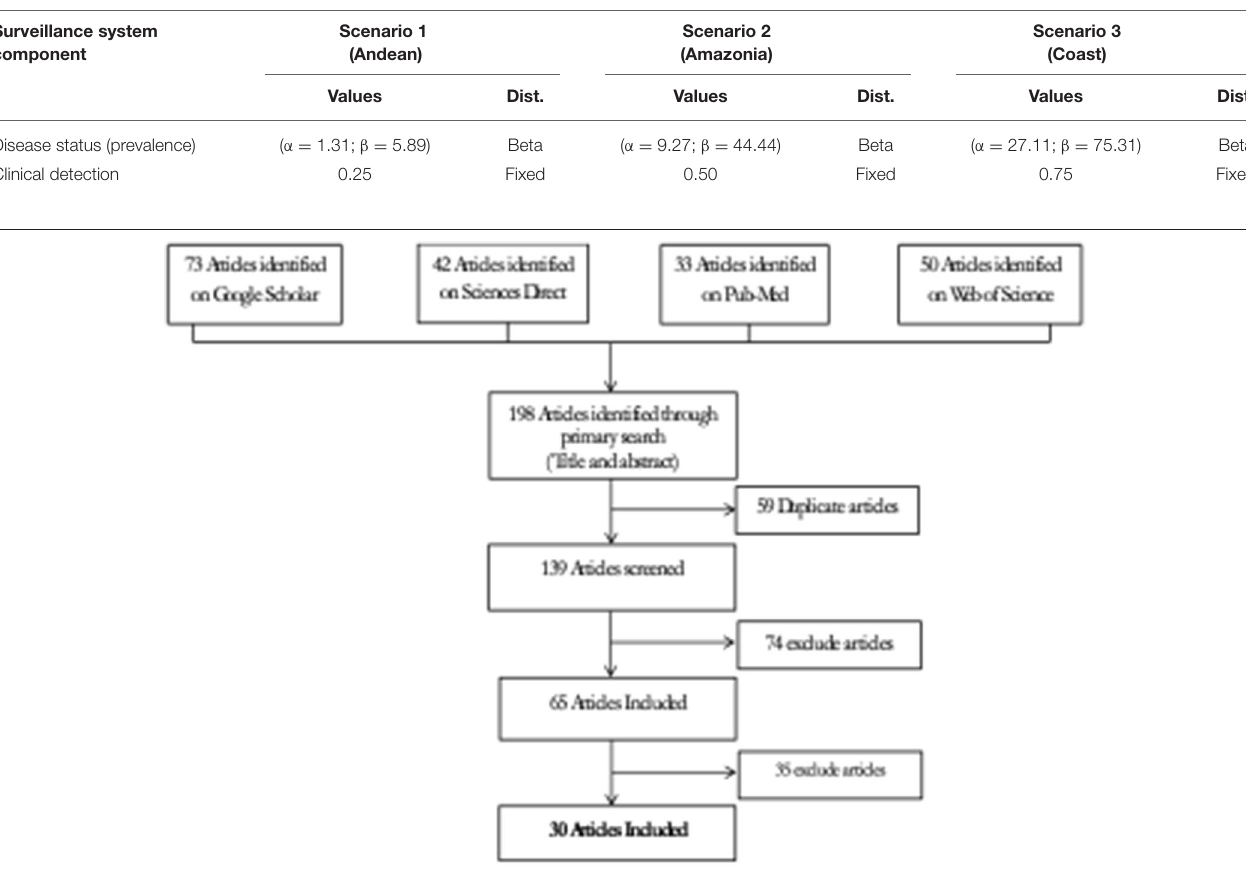
TABLE 2 | Probabilities from specific surveillance system components (disease status and clinical detection) for different geographical areas, of the current surveillance system for human leptospirosis in Ecuador. Surveillance system component